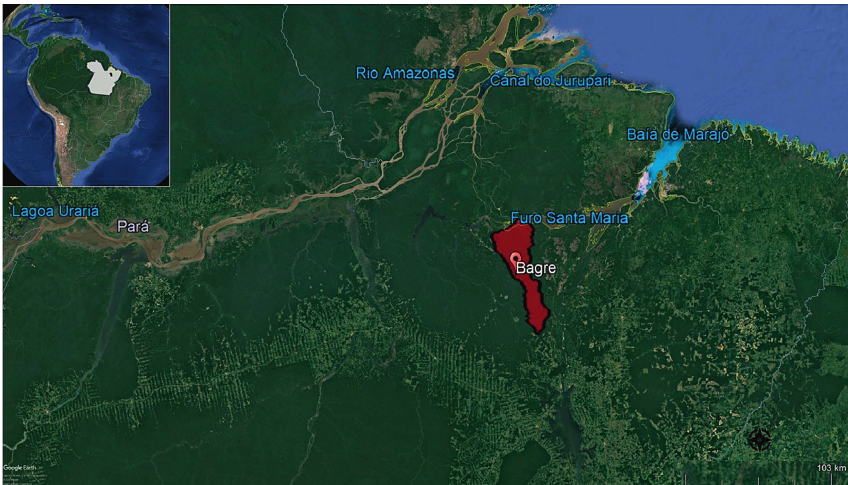
Figure 1: Map of the study area demonstrating the urban districts of Bagre and the Maraj´o Archipelago, Par´a State, Brazilian